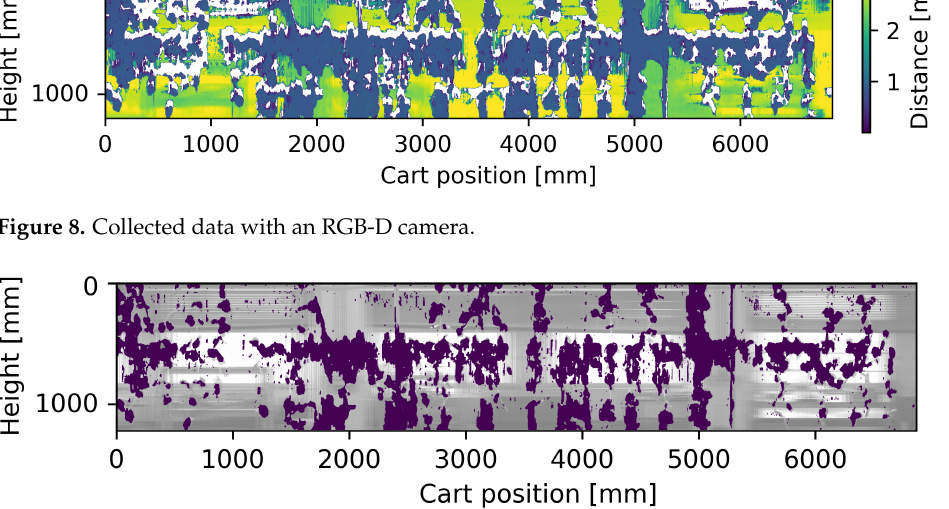
Figure 9. Estimated profile of vineyard with RGB-D camera superimposed on the panoramic image of the test